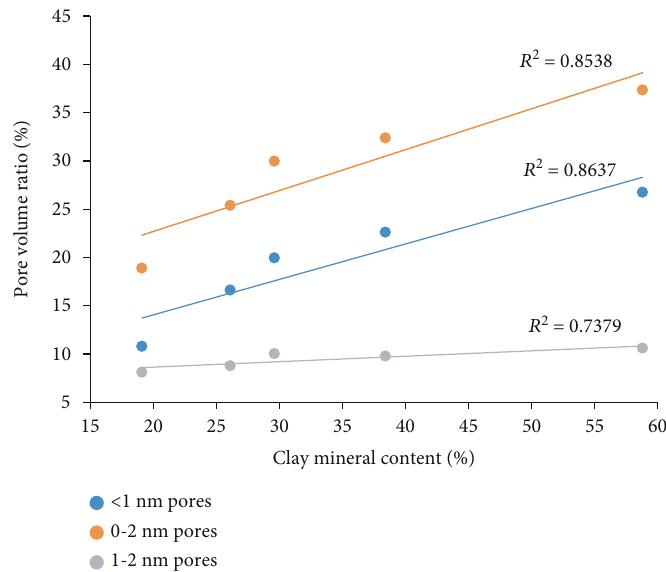
Figure 7: Relationship between the clay mineral content and pore volume ratio.